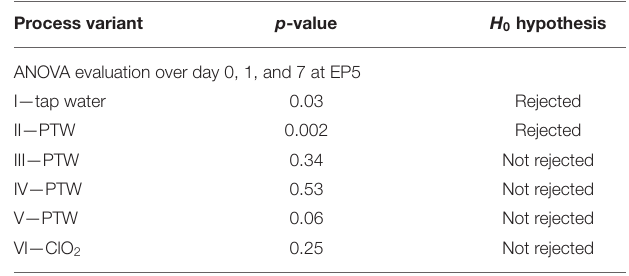
TABLE 6 | Statistical evaluation of storage day 0.